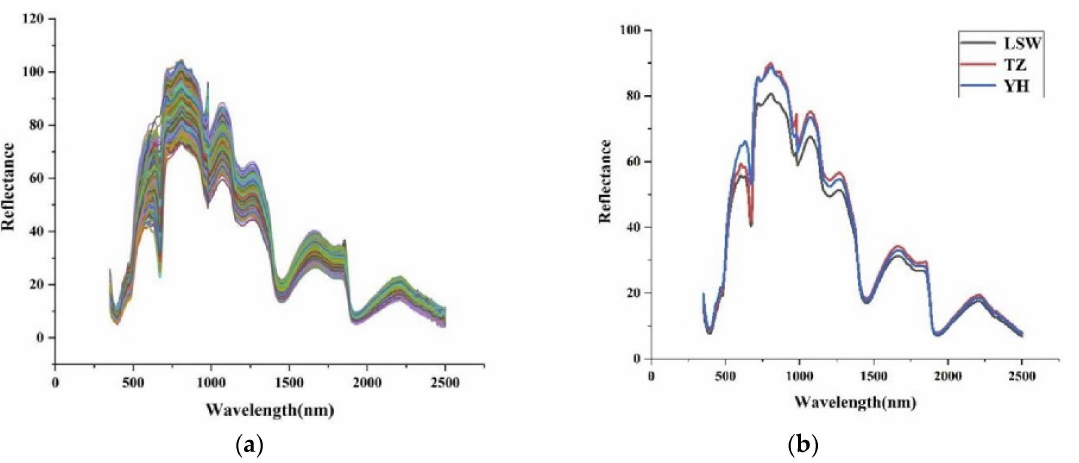
Figure 4. Spectral data of pear samples in 2020.( a ) Original reflectance spectral profile of pear samples in the wavelength range of 350–2500 nm. ( b ) Average original reflectance spectral profile of pear samples from three